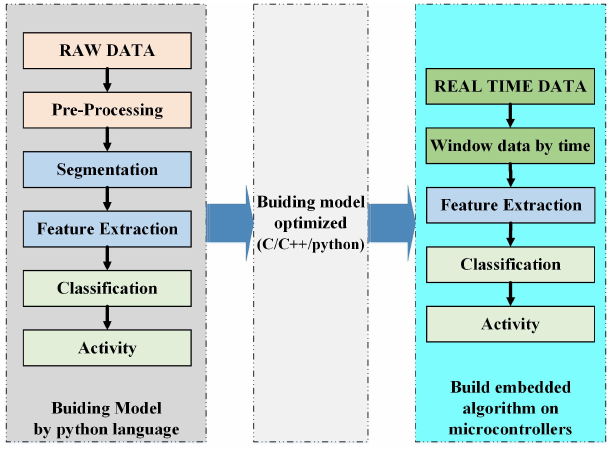
Fig 15. Construction diagram of the recognition